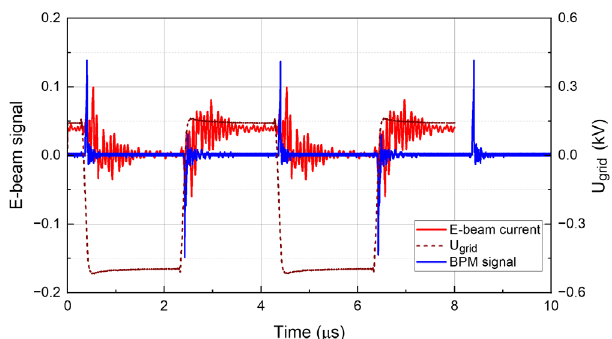
FIG. 3. Modulated voltage on the grid electrode (dash), pulsed electron beam current (red), and BPM signal (blue) generated by the pulsed electron beam in the experiment. The noise of the current signal comes from the